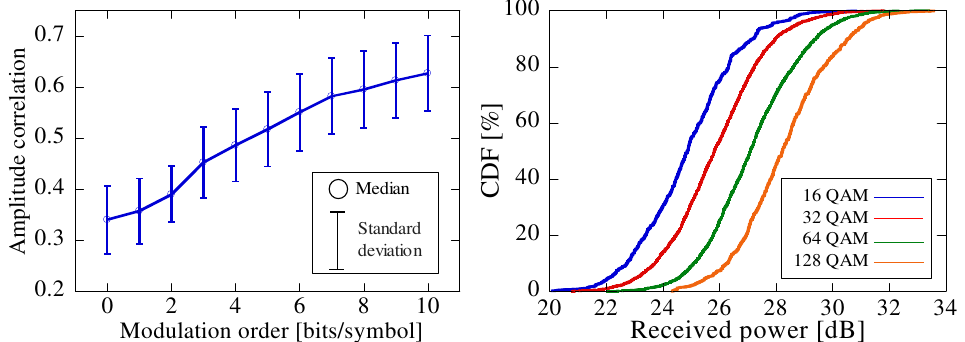
Figure 5. Relationships between applicable modulation scheme and amplitude correlation ( left ) and received power ( right